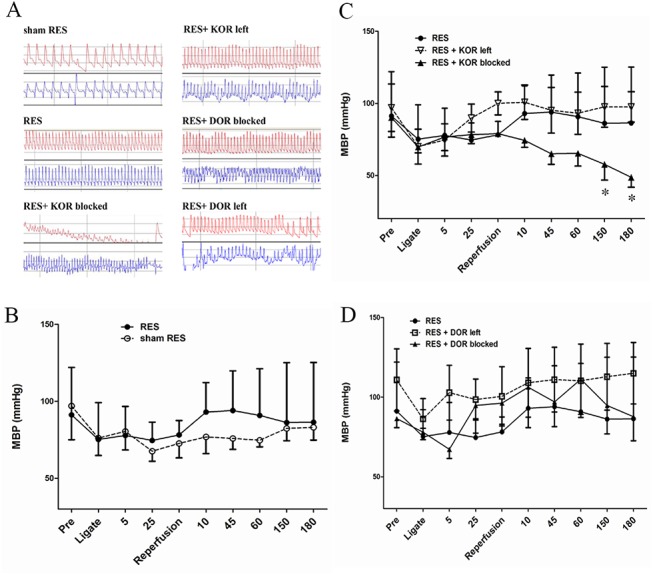
The role of different opioid receptors subtype in hemodynamic changes of preconditioned remote electro-stimulation (RES)-induced myocardial protection against ischemia/reperfusion (I/R) injury.Animals were randomly allocated into 6 groups as described in Methods. They were 1) sham RES group (n = 24); 2) RES preconditioning group (n = 20); 3) RES preconditioning pretreated with KOR blocker (n = 18); 4) RES preconditioning pretreated with DOR blocker (n = 10); 5) RES preconditioning pretreated with KOR/MOR antagonists, which left DOR active (n = 11); 6) RES preconditioning pretreated with DOR/MOR antagonists, which left KOR active (n = 9). During I/R injury period, the hemodynamic changes in these animals were continuously monitored (A). The results showed that preconditioned RES seemed to maintain a higher mean arterial pressure (MAP) than the sham RES group (B). It was of note that there was a significant decreased MAP in preconditioned RES + KOR blocked group (C), but not in preconditioned RES + DOR blocked group (D), compared to the preconditioned RES group. *, p<0.05, vs. sham RES. KOR, kappa opioid receptor; DOR, delta opioid receptor; MOR, mu opioid receptor; KOR left, KOR activity remained; DOR left, DOR activity remained; MOR left, MOR activity remained.